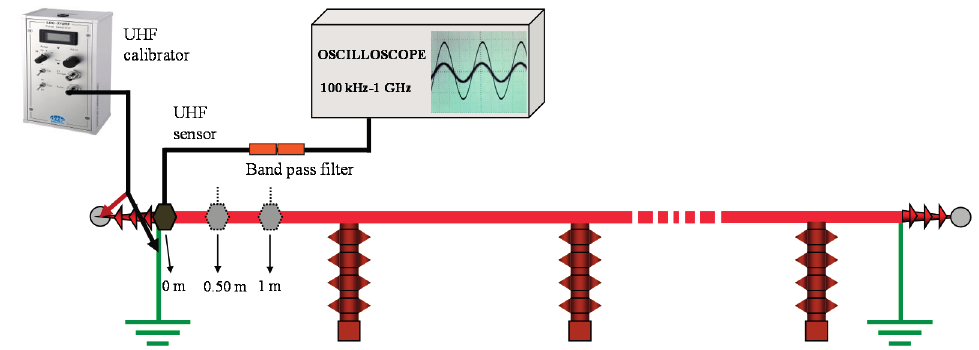
Figure 5. Experimental setup for the evaluation of the UHF frequency components of a PD pulse in a power cable.